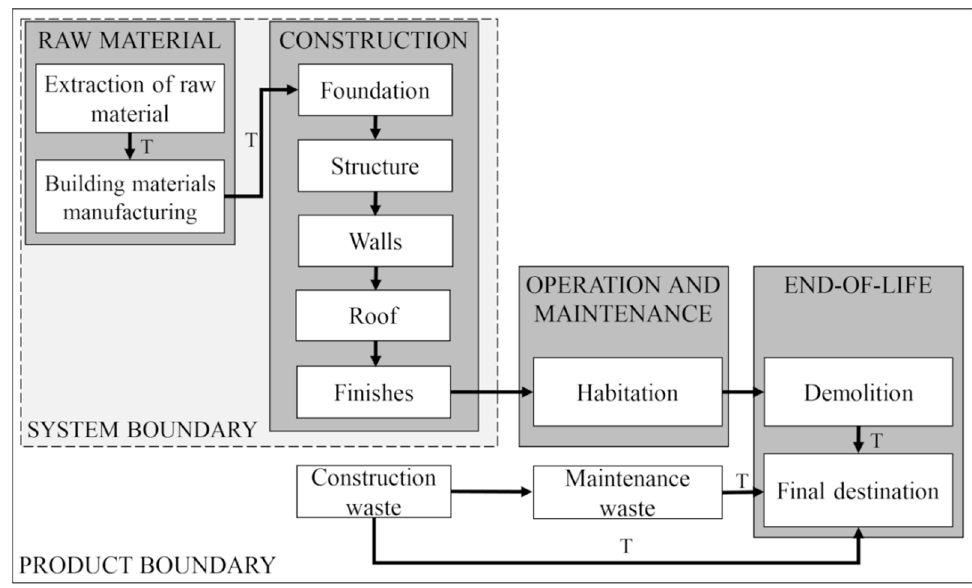
Figure 3. Product system and study system boundary.